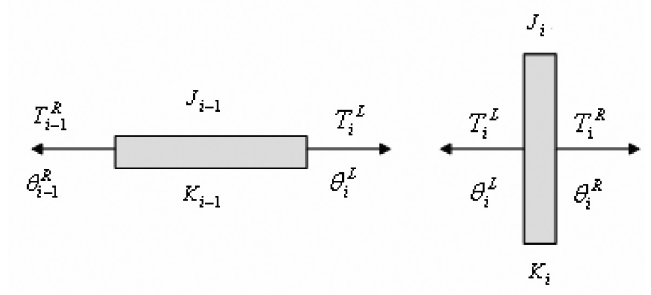
Fig. 2. Dynamical characteristic